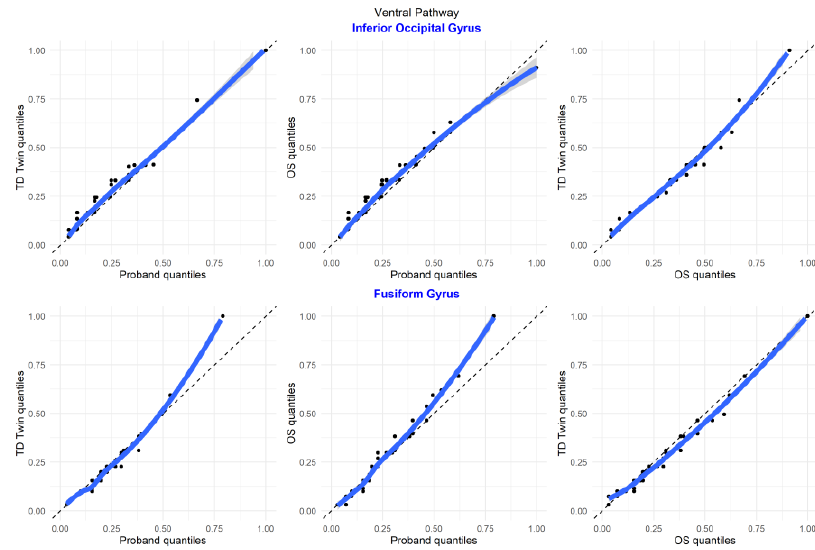
Figure 6. Q – Q plots of sibling comparisons of regions in the ventral pathway. Figure 6. Q–Q plots of sibling comparisons of regions in the ventral